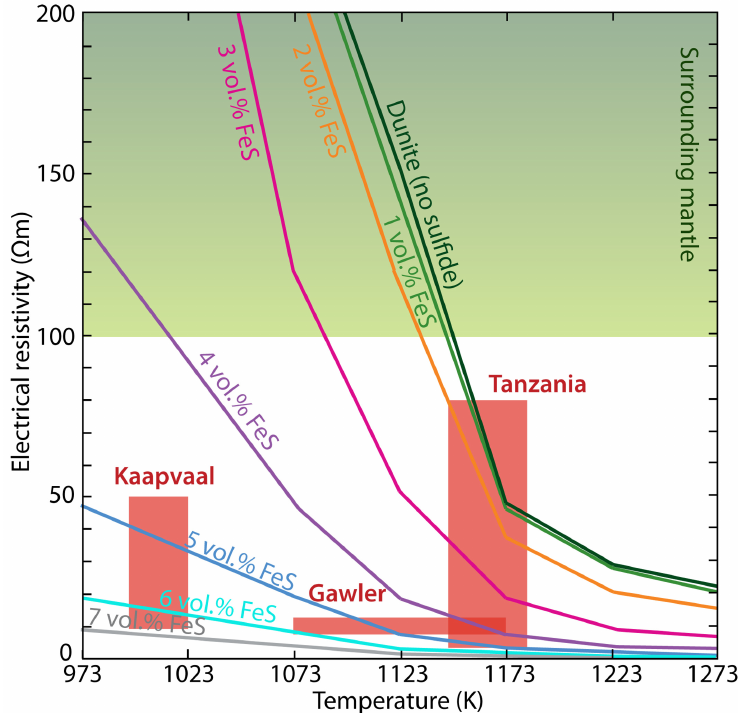
Figure 10. The sulfide content required to interpret the observed high-conductivity at different cratonic contexts according to the electrical laboratory measurements